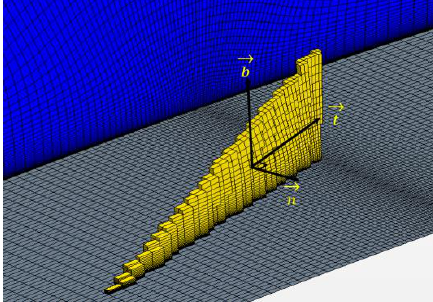
Figure 4. Cell-made representation of the triangular VG with the jBAY source-term model.